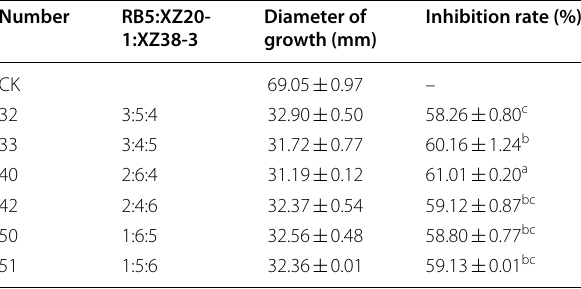
Different letters in the same column indicate significant differences ( P <